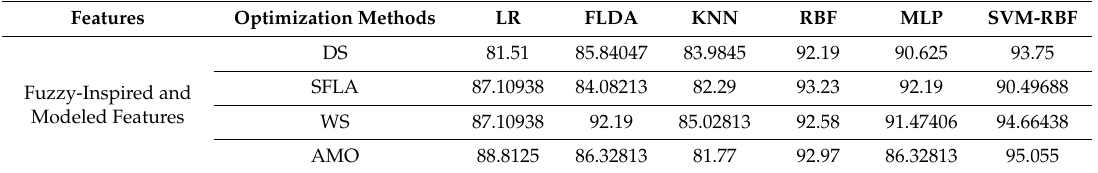
Table 11. Consolidated results of accuracy (%) among the classifiers at various optimization techniques with di ff erent features for CVD cases.